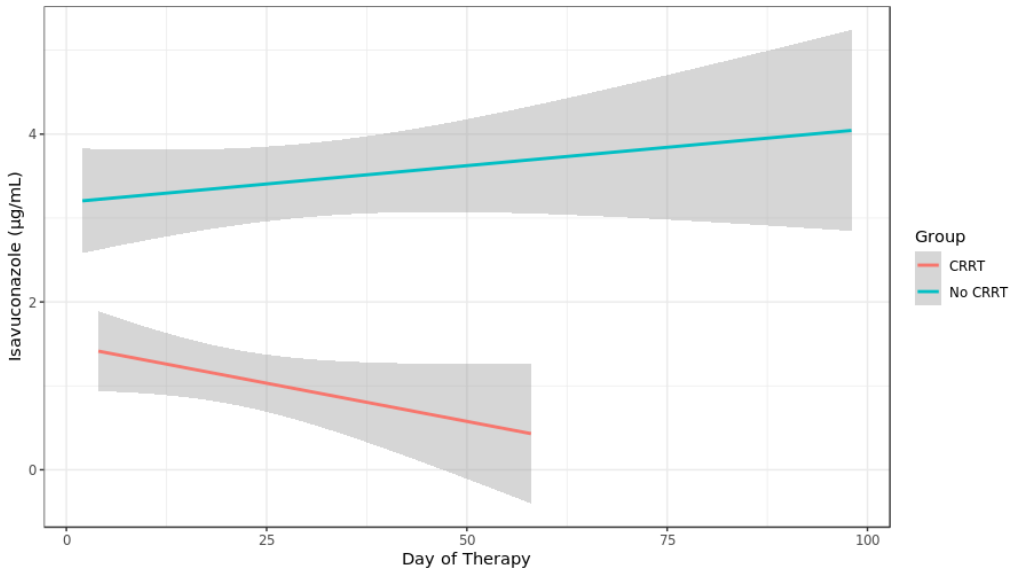
Figure 2. Spaghetti plot of Isavuconazole plasma concentration in patients with and without continuous renal replacement therapy (CRRT).